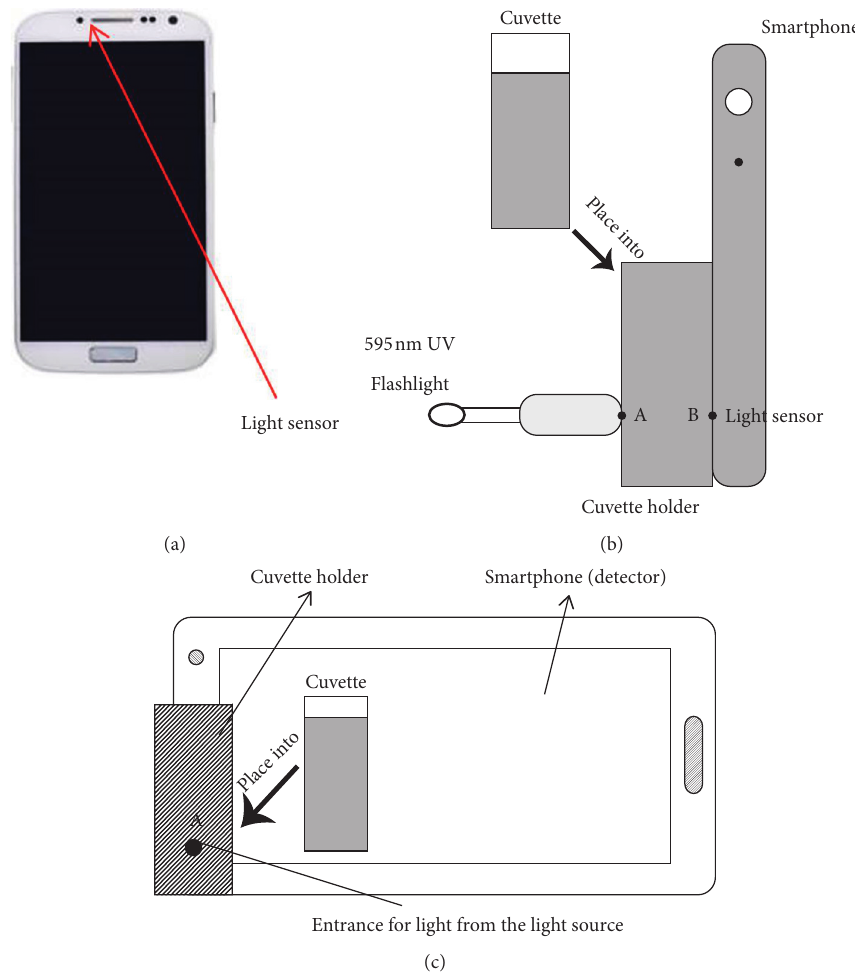
Figure 2: Experimental setup. (a) The location of the smartphone’s sensors. (b) Side view of the instrument. (c) Front view of the instrument.